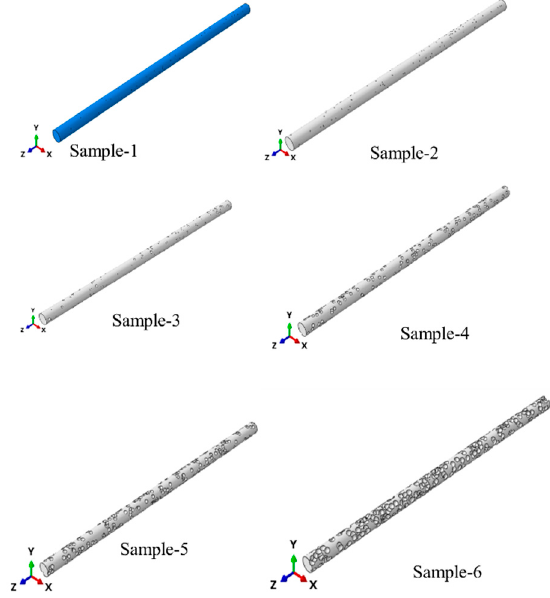
Figure 7. Correlation between experimental life and predicted life.